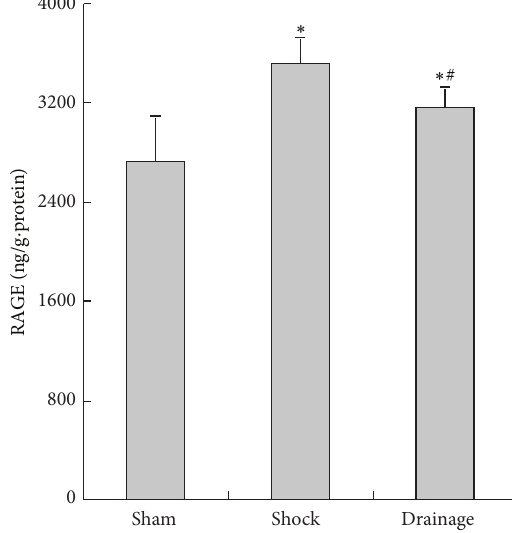
Figure 8: Effects of mesenteric lymph drainage on RAGE contents of renal homogenate in hemorrhagic shock rats without resuscita- tion (ng/g ⋅ protein, mean ± SD, 𝑛 = 6 ). ∗ 𝑃 < 0.05 versus sham group; # 𝑃 < 0.05 versus shock group.